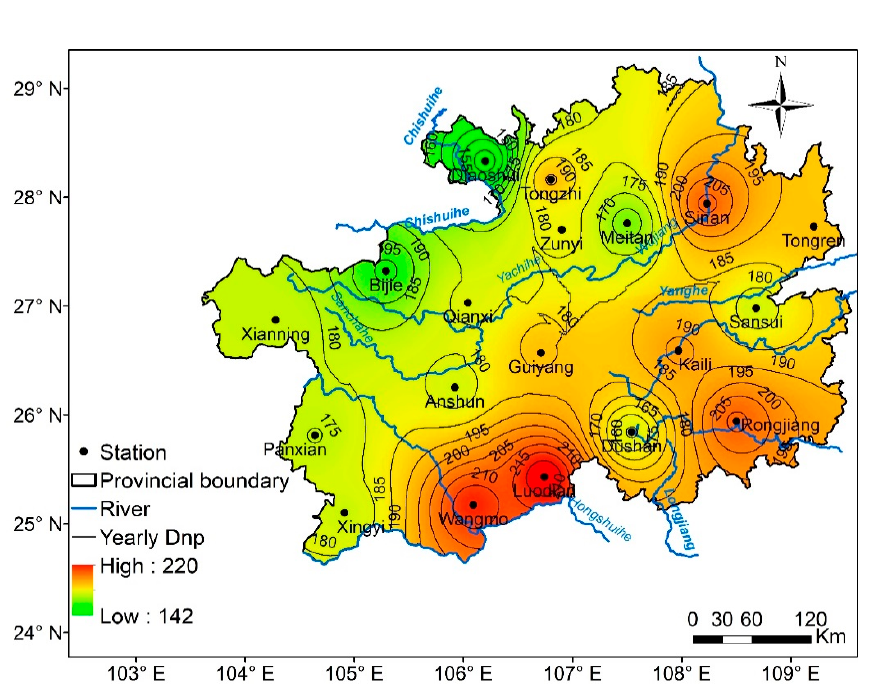
Figure 2. The spatial distribution of meteorological stations in Guizhou.